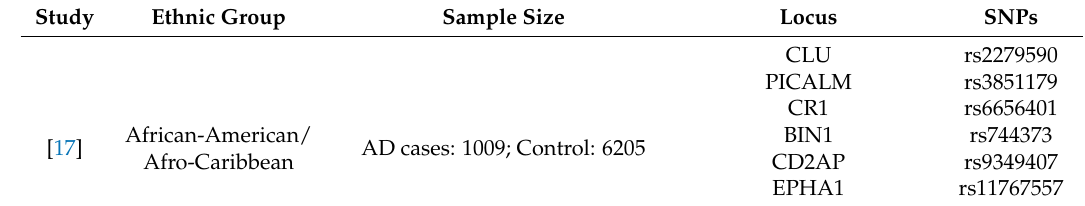
Table 1. Genome-wide association studies (GWAS) in